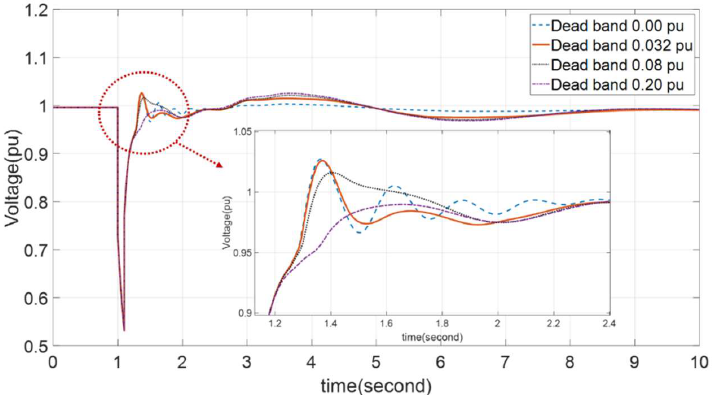
Figure 12. Voltage profile due to large disturbance. Table 4. Performance indicators result according to dead band range.